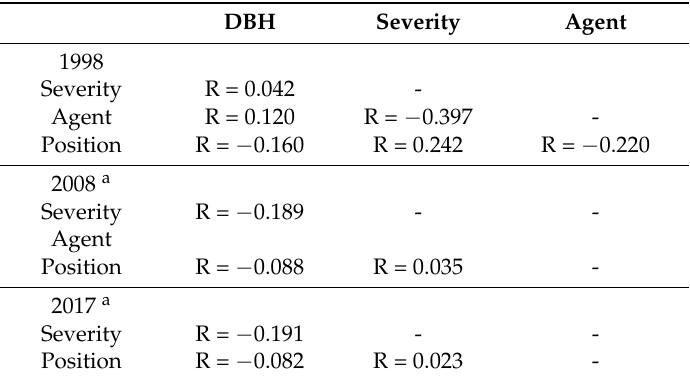
Table 6. Correlation matrix among diameter at breast height, damage severity, agent, and position (Spearmann R, p < 0.05 in bold) after thinning in 1998 (N. = 135), 2008 (N. = 138) and 2017 (N. = 140). Severity, agent, and position were ranked as in Tables 3–5.